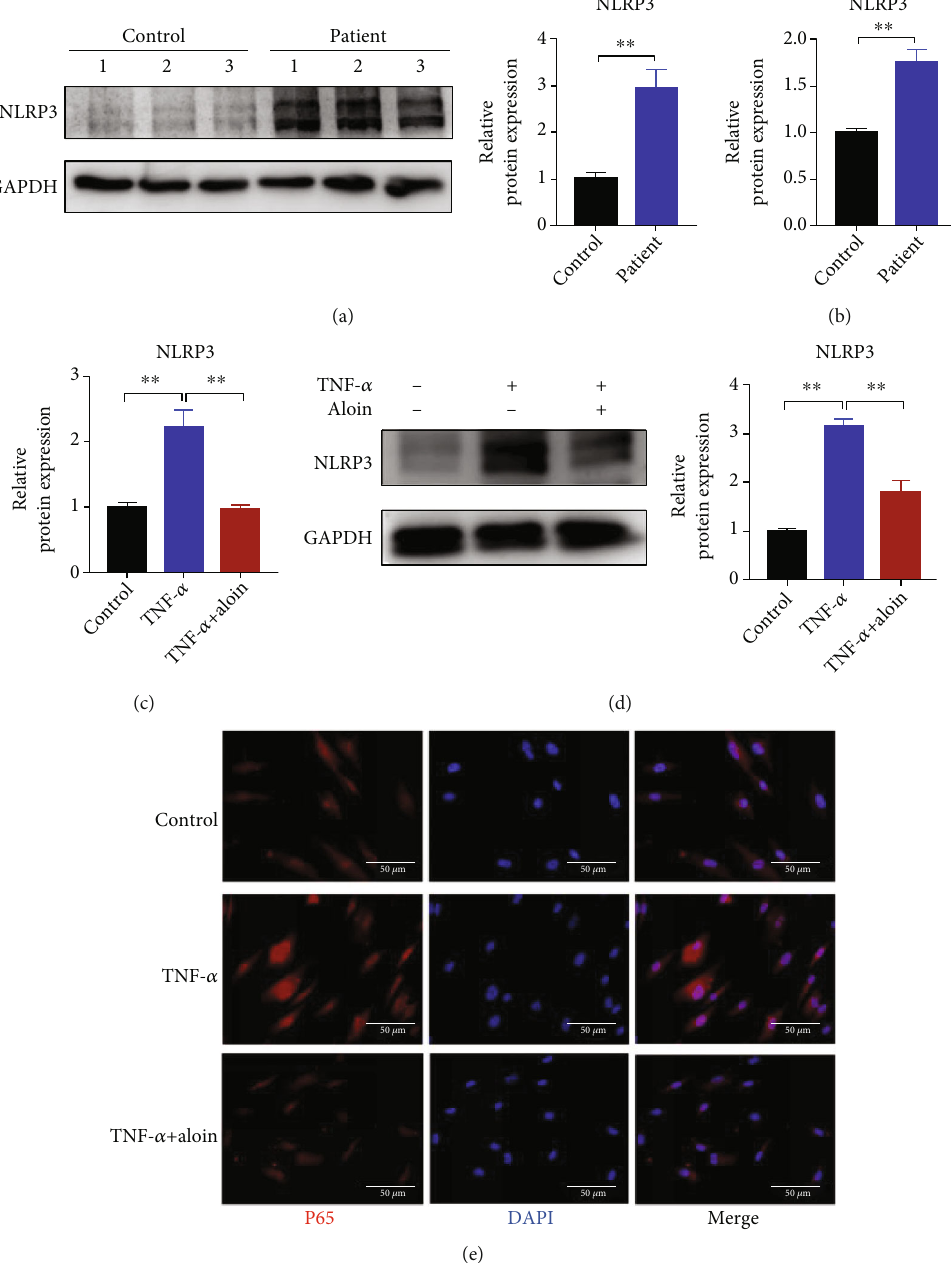
Figure 6: Aloin treatment inhibits the expression of the NLRP3 in fl ammasome. (a) The expression level of NLRP3 was detected by western blot in normal and degenerated human NP tissues. The protein bands were quanti fi ed using the ImageJ software. (b) The mRNA level of NLRP3 was detected by qPCR in normal and degenerated human NP tissues. (c) The mRNA expression of NLRP3 was detected by qPCR in the di ff erent groups. (d) The expression of NLRP3 was detected at the protein level by western blotting (left panel). The protein bands were quanti fi ed by the ImageJ software (right panel). (e) NLRP3 detection by using immuno fl uorescence. Images (magni fi cation: × 400, scale bar: 50 μ m). In this fi gure, aloin was used at the concentration of 200 μ M, while TNF- α was at the concentration of 10ng/ml. ∗ P < 0 : 05 , ∗∗ P < 0 : 01